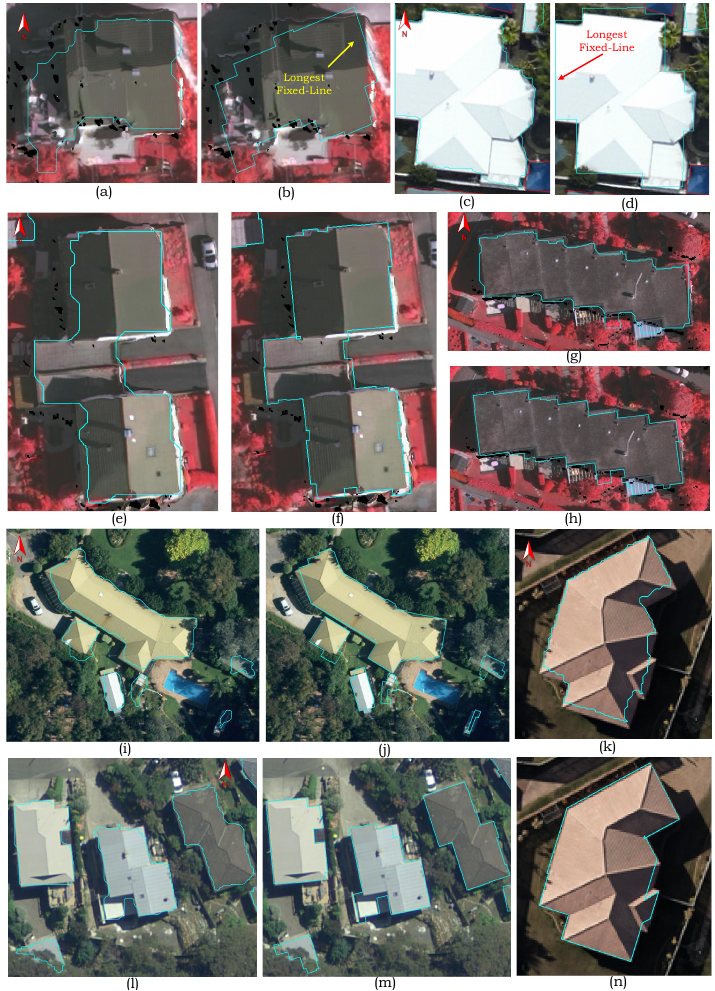
Figure 16. Building examples from ISPRS and Australian data sets. Detected and regularised buildings on ( a , b ) VH Area 3; ( c , d ) AV; ( e , f ) VH Area 3; ( g , h ) VH Area 2; ( i , j ) EL; ( k , l ) HT; and ( m , n )